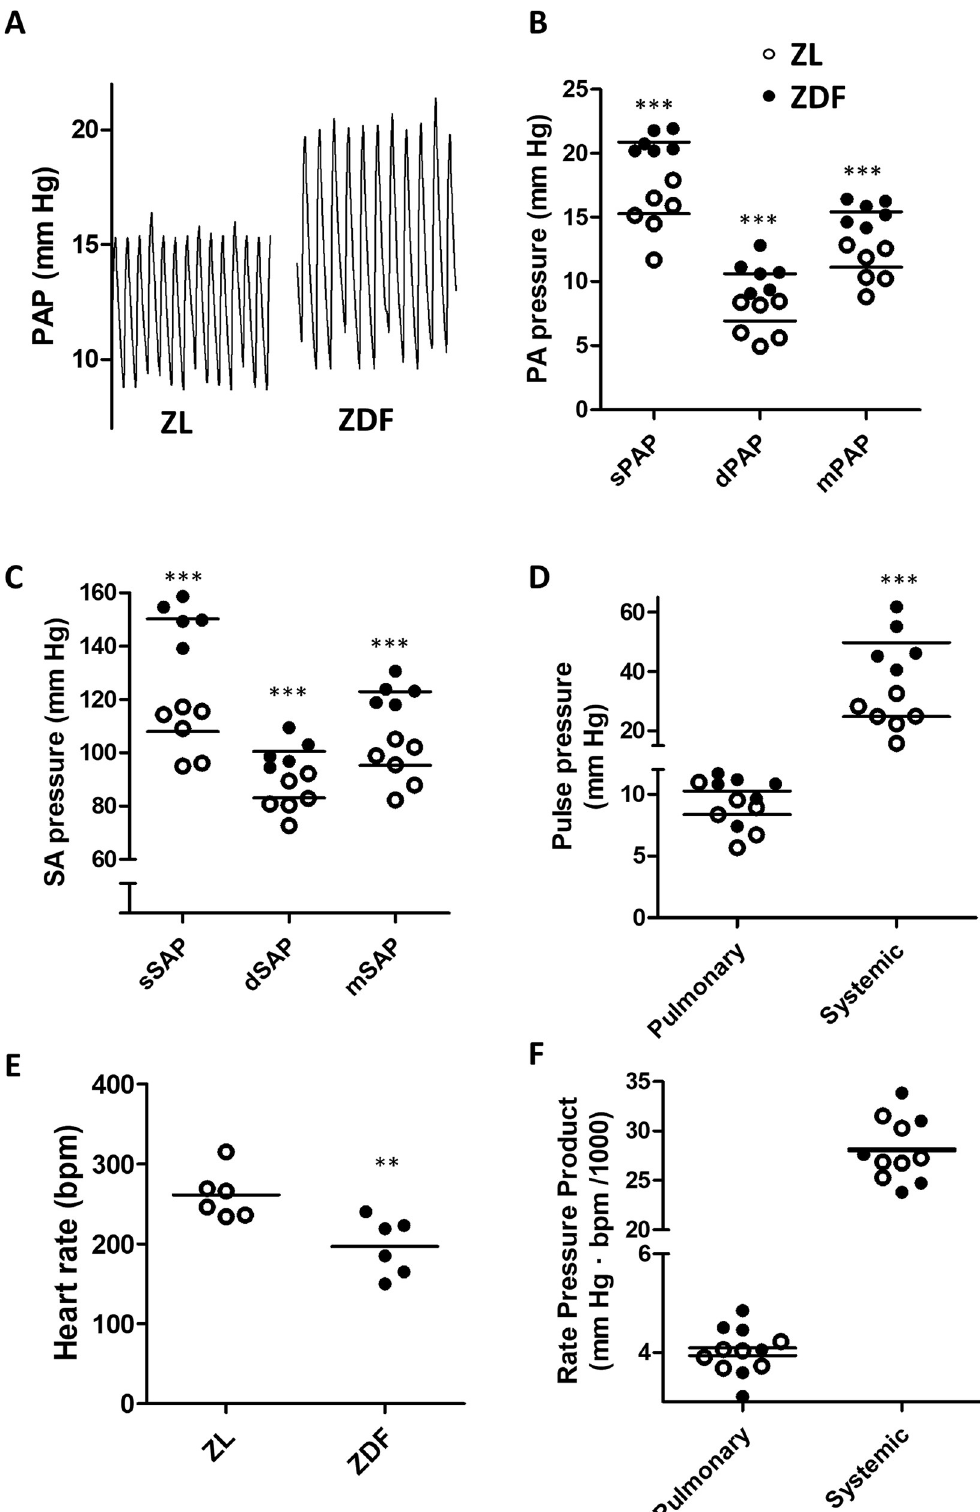
Fig 1. ZDF rats show increased pulmonary and systemic arterial pressure. (A) Typical pulmonary arterial pressure (PAP) recordings. (B) Systolic, diastolic and mean PAP. (C) Systolic, diastolic, and mean systemic arterial pressure (SAP).